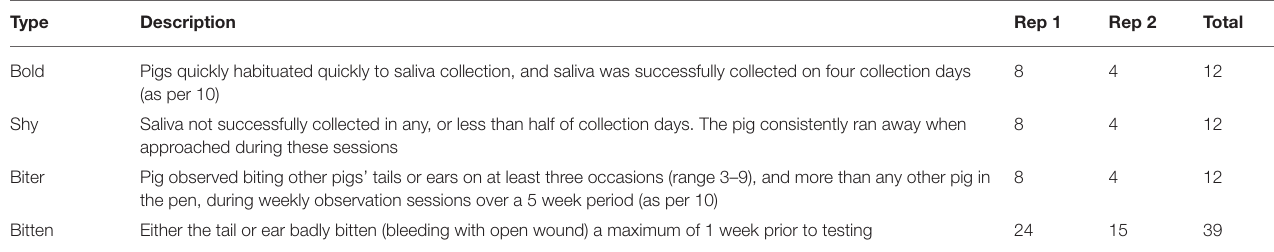
TABLE 2 | Numbers of pigs selected within each type for open field and novel object testing.